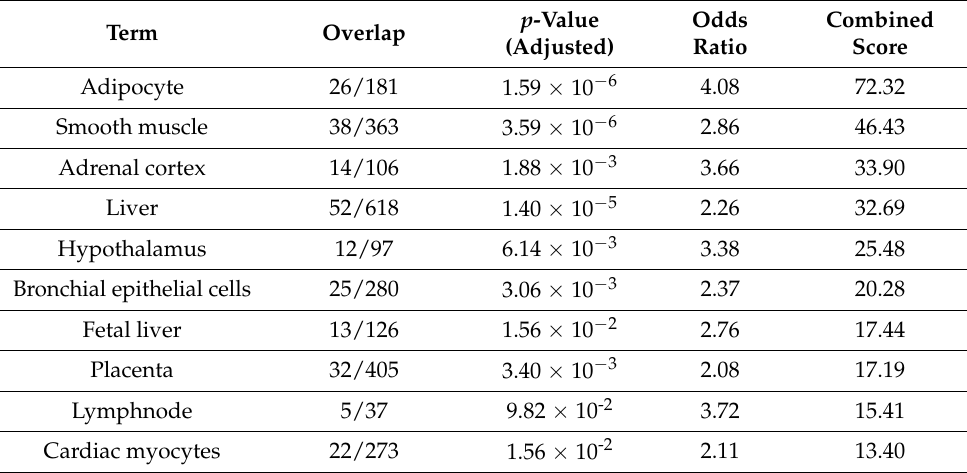
Table 2. Top 10 tissues targeted by compounds of